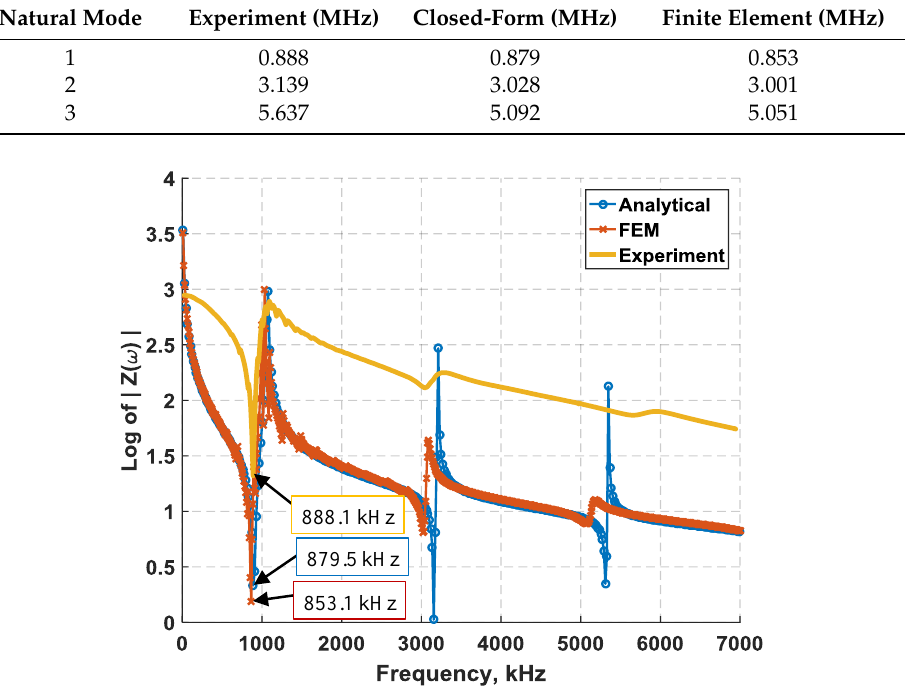
Figure 2. Piezoelectric response of a shear-mode piezoelectric transducer obtained using the analytical approach, finite element, and experiment.